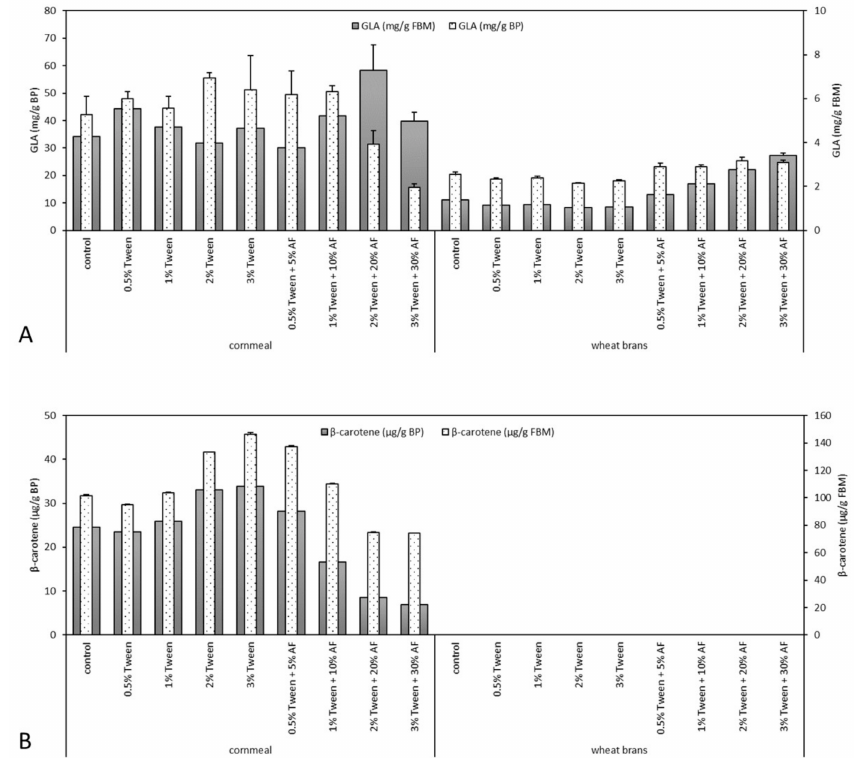
Figure 1. Content of γ -linolenic acid (GLA) ( A ) in fermented bioproducts (BP) and fungal biomass (FBM) and β -carotene yields ( B ) in BP and FBM. AF—animal fat by-product. Error bars showed a standard deviation, α = 0.05.